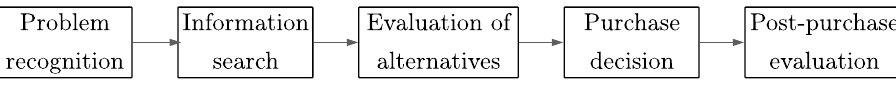
Figure 1. The classical model of consumer purchase decision